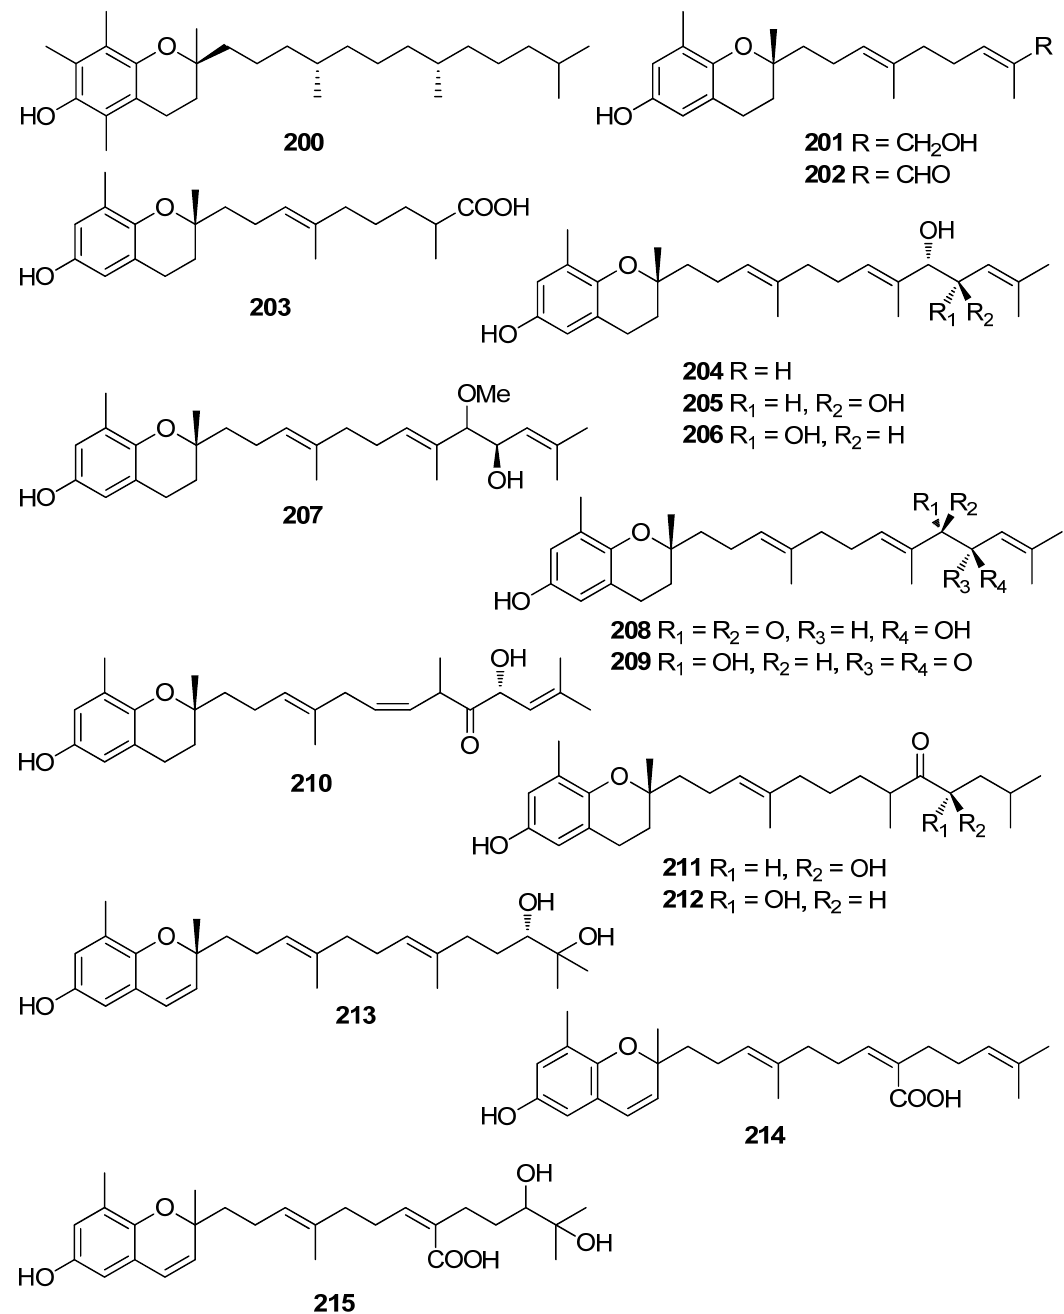
Figure 18. Chemical structures of compounds 200 – 215 .